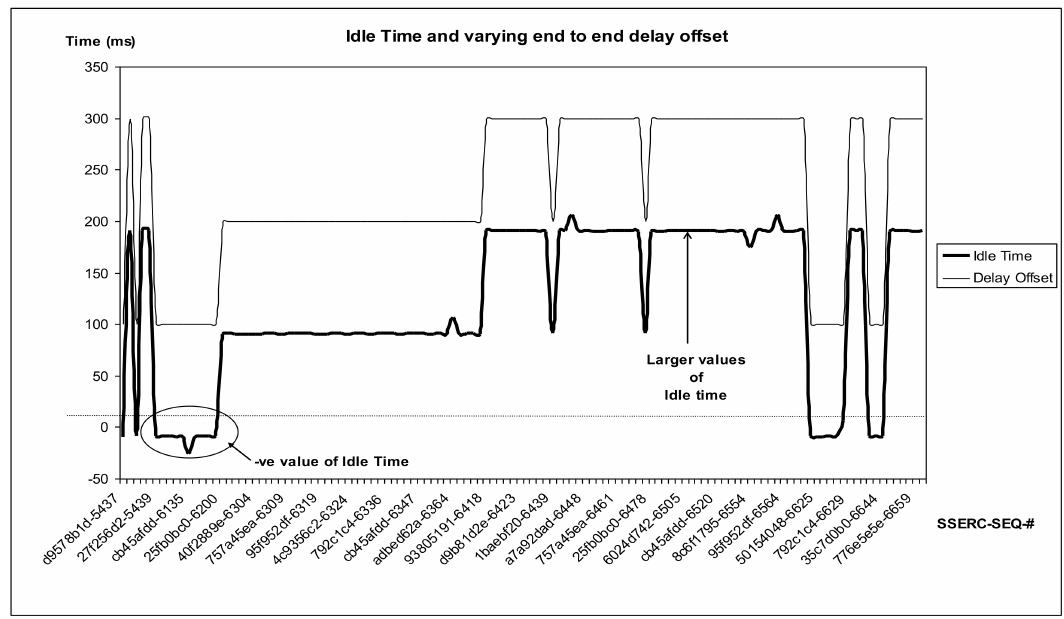
Figure 14. End-to-end delay offset and its effect on idle